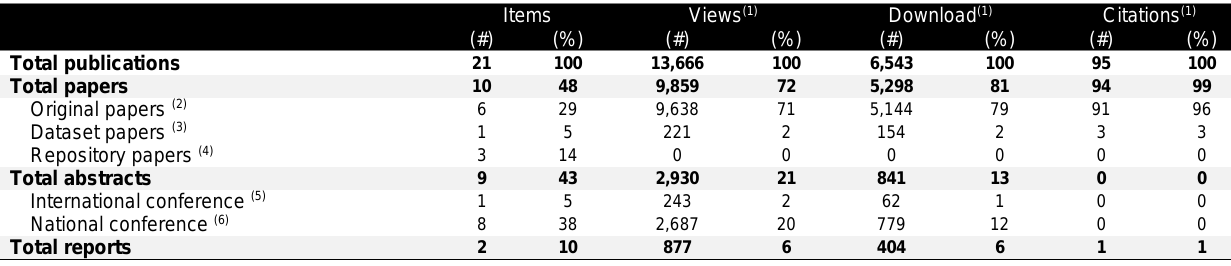
Table 1: Number and percentage of views, downloads, and citations of each type of publication focusing on the health service delivery and health economic evaluation of limb lower bone-anchored prostheses produced by the Queensland Artificial Limb Service (QALS)